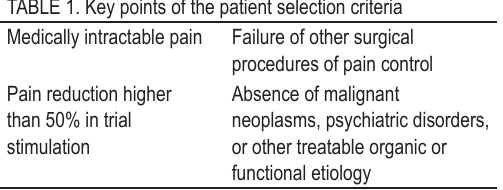
TABLE 1. Key points of the patient selection criteria Medically intractable